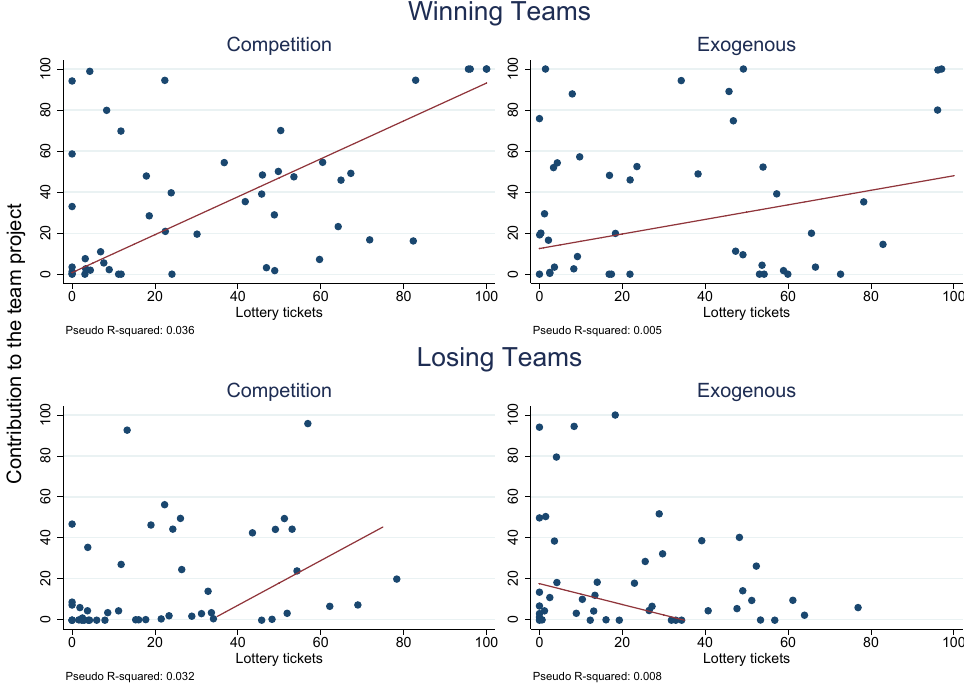
Figure 4. Relationship between first stage and second stage contribution and fitted regression line.